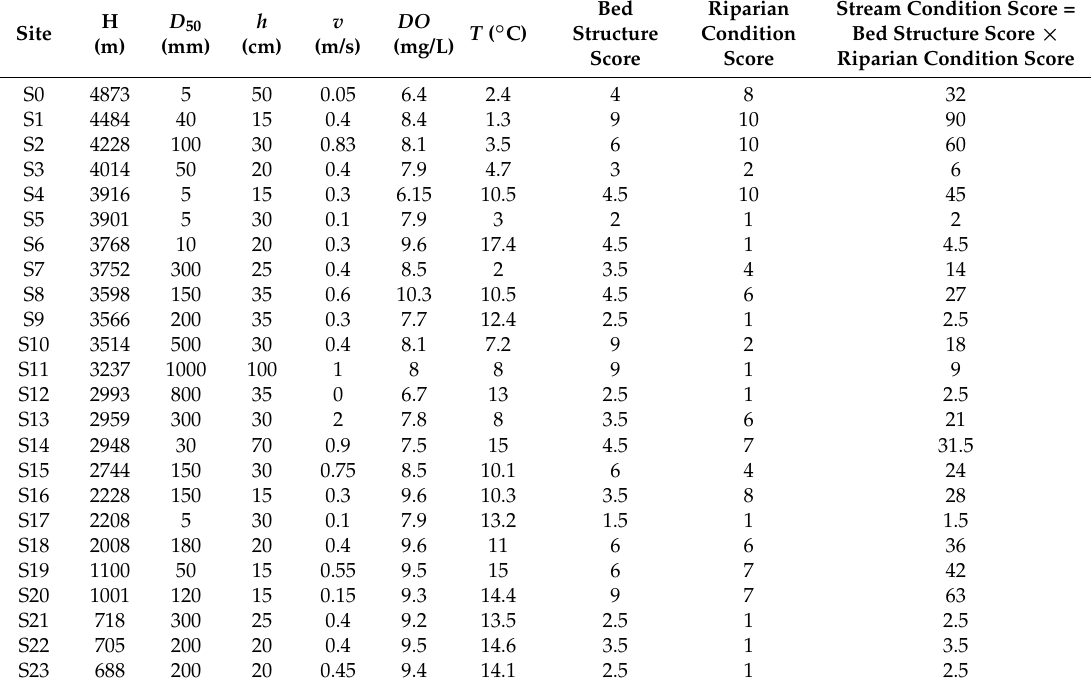
Table A1. Values assigned for the environmental parameters of the sites in the Yalutsangpo basin for